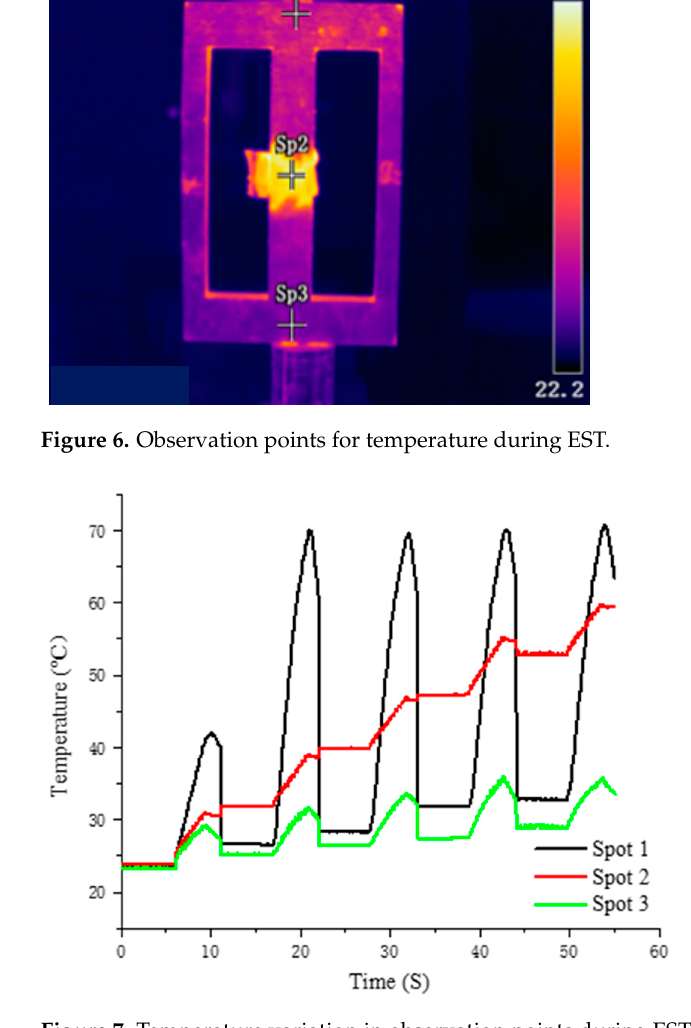
Figure 7. Temperature variation in observation points during EST.